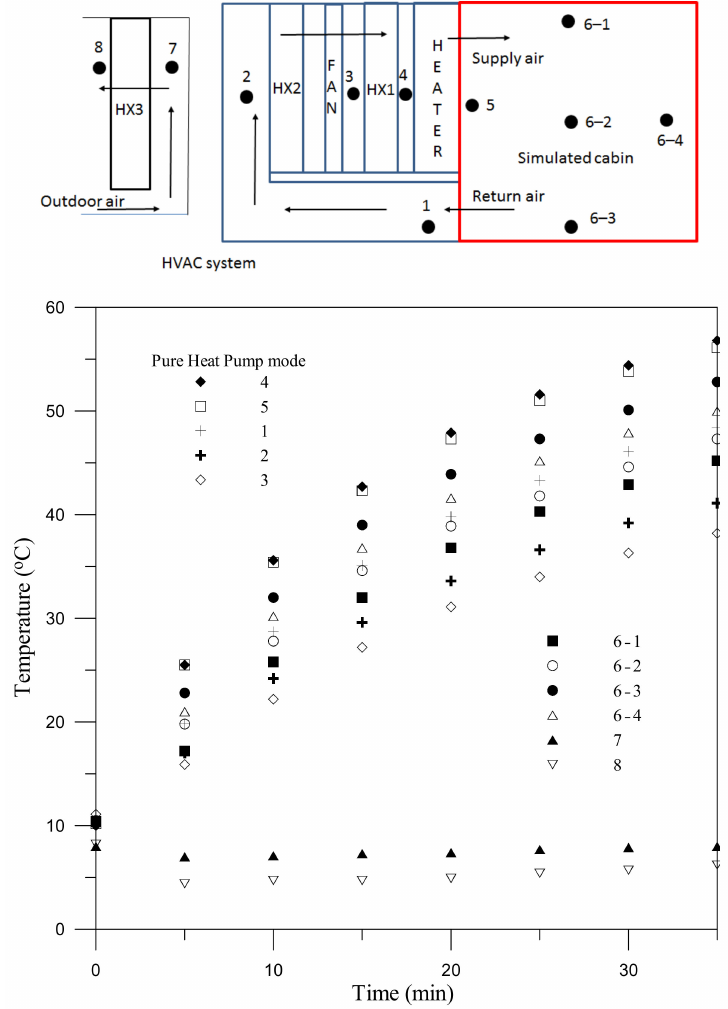
Figure 5. Temperature distribution in PHP